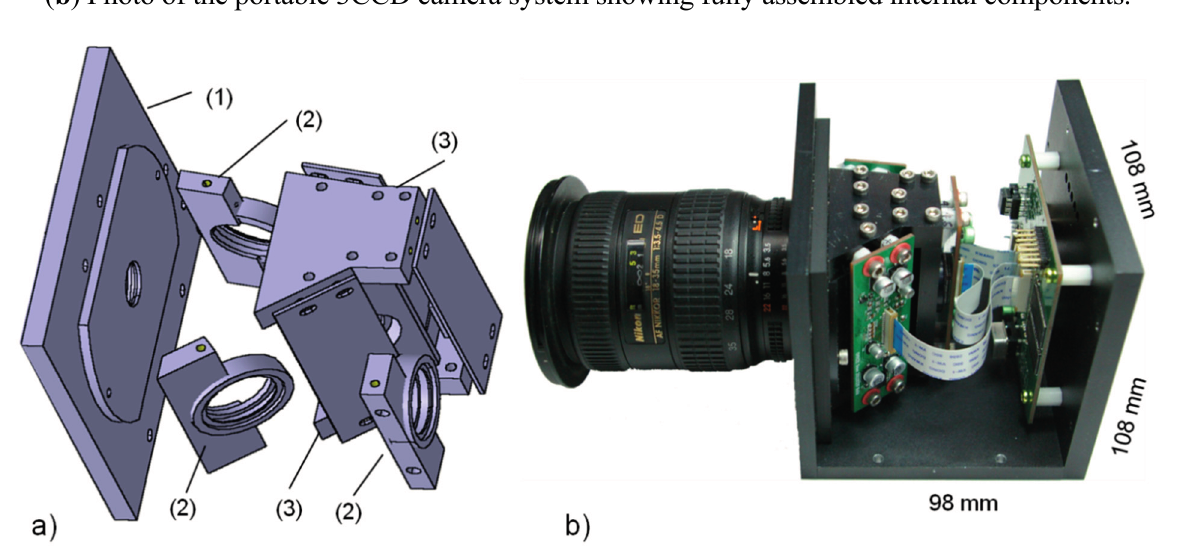
Figure 6. ( a ) 3D illustration of internal frame/structure of the portable 3CCD camera system: (1) F-mount lens holder; (2) interference filter holders; and (3) prism assembly